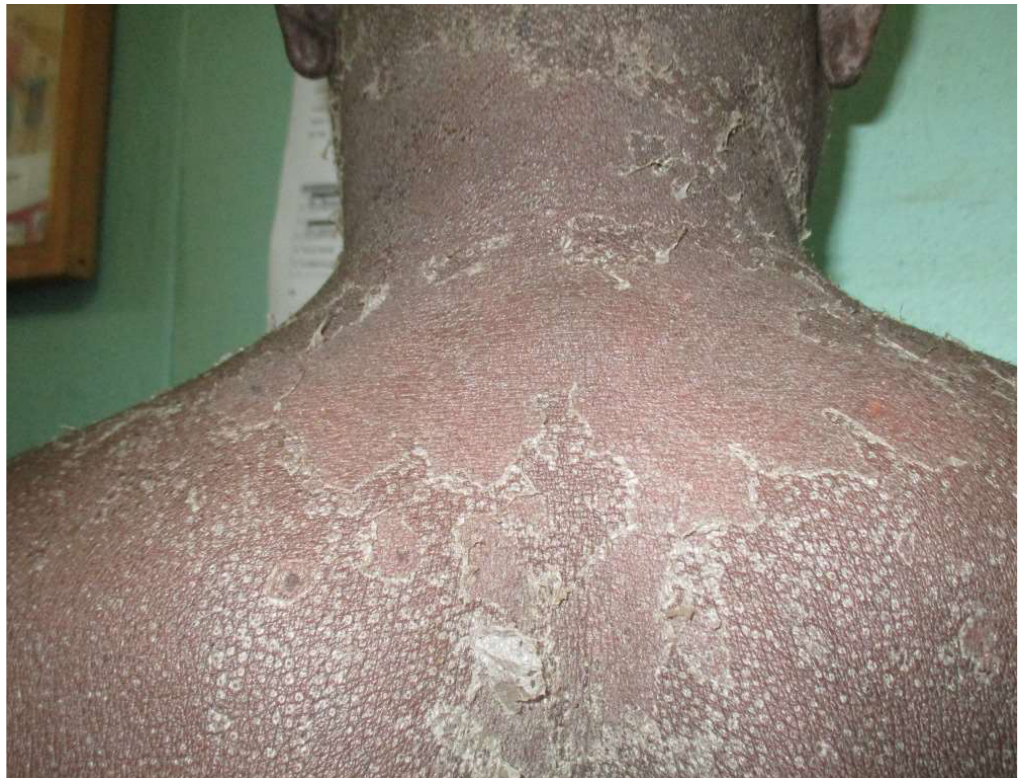
Figure 2. Drug eruption caused by amoxicillin intake following dental extraction.